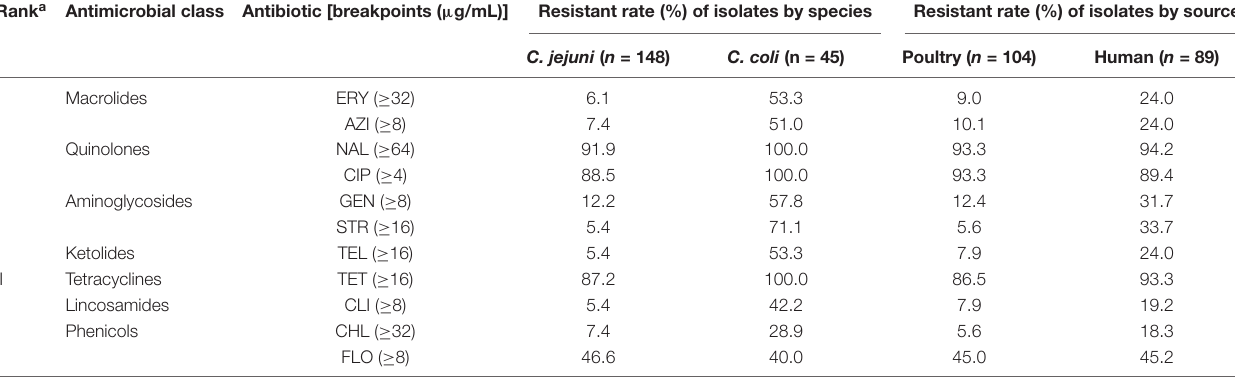
TABLE 2 | Antimicrobial resistant rate of Campylobacter isolates from different species and sources against eleven antimicrobials. Rank a Antimicrobial class Antibiotic [breakpoints ( µ g/mL)] Resistant rate (%) of isolates by species Resistant rate (%) of isolates by sources